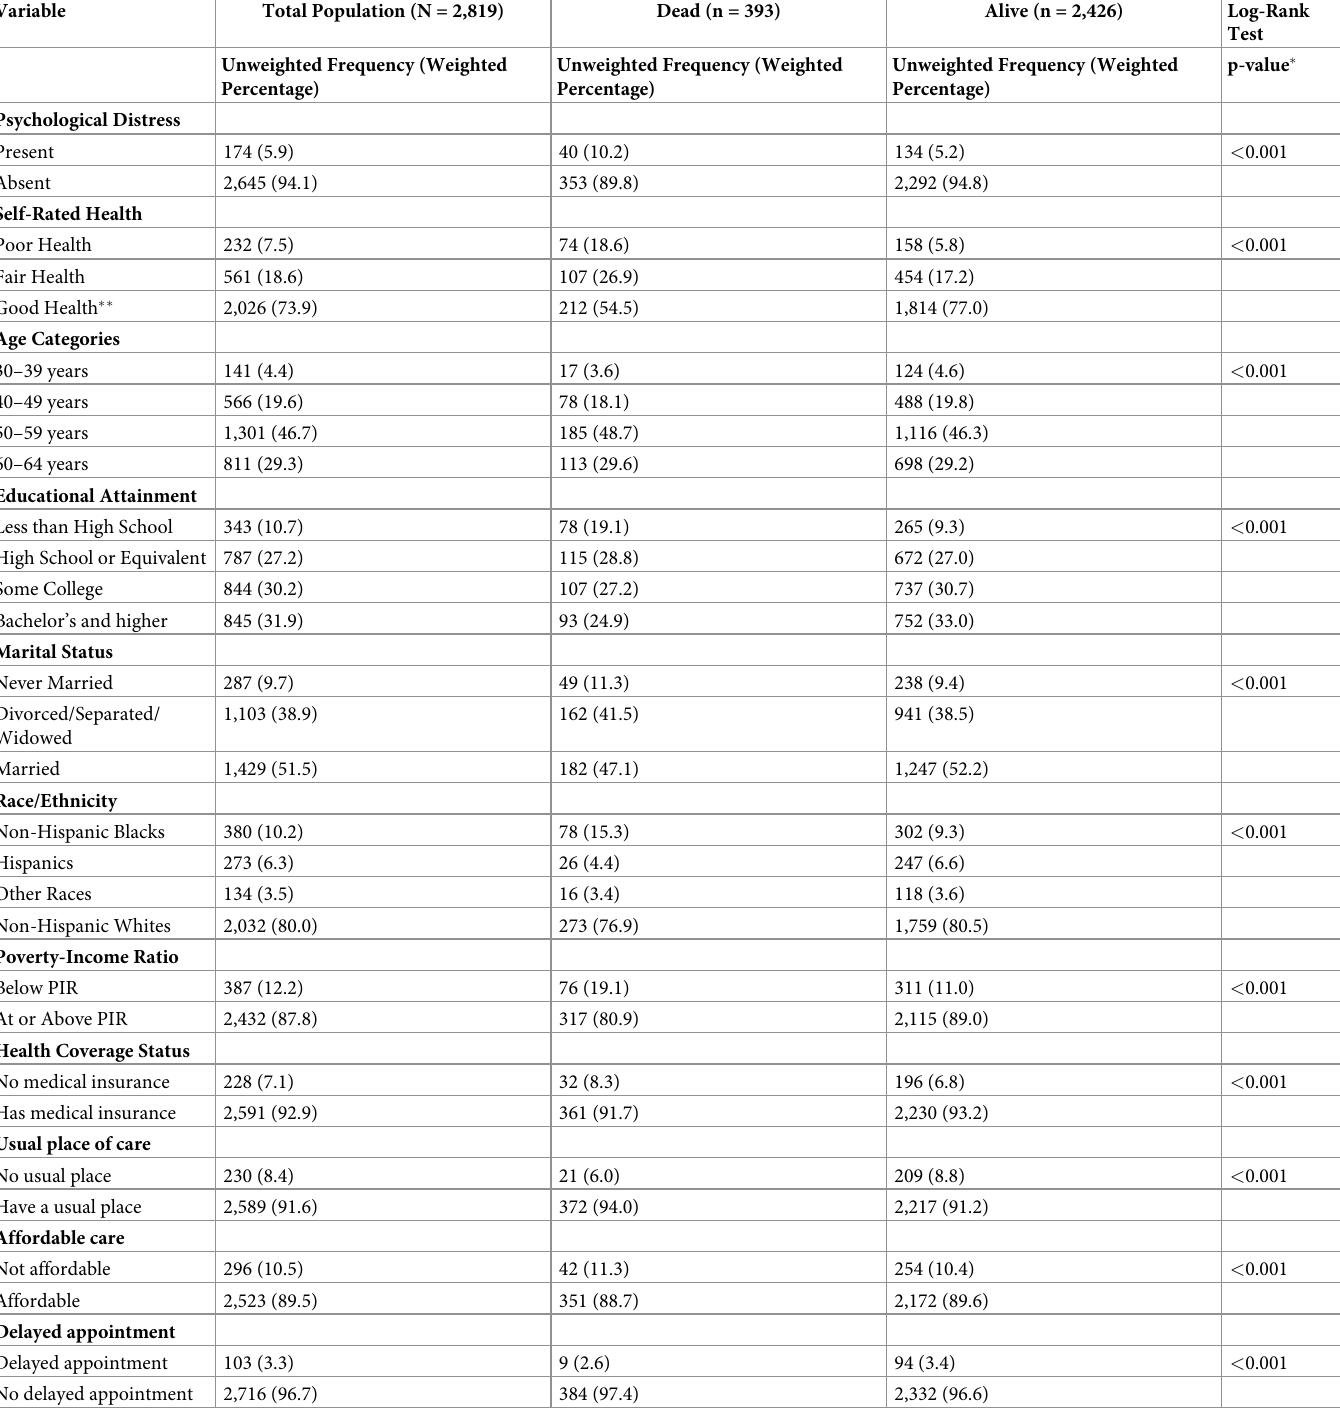
Table 1. Frequency distribution and association between mortality status and psychological distress, self-rated health, sociodemographic characteristics, and mea- sures of health care